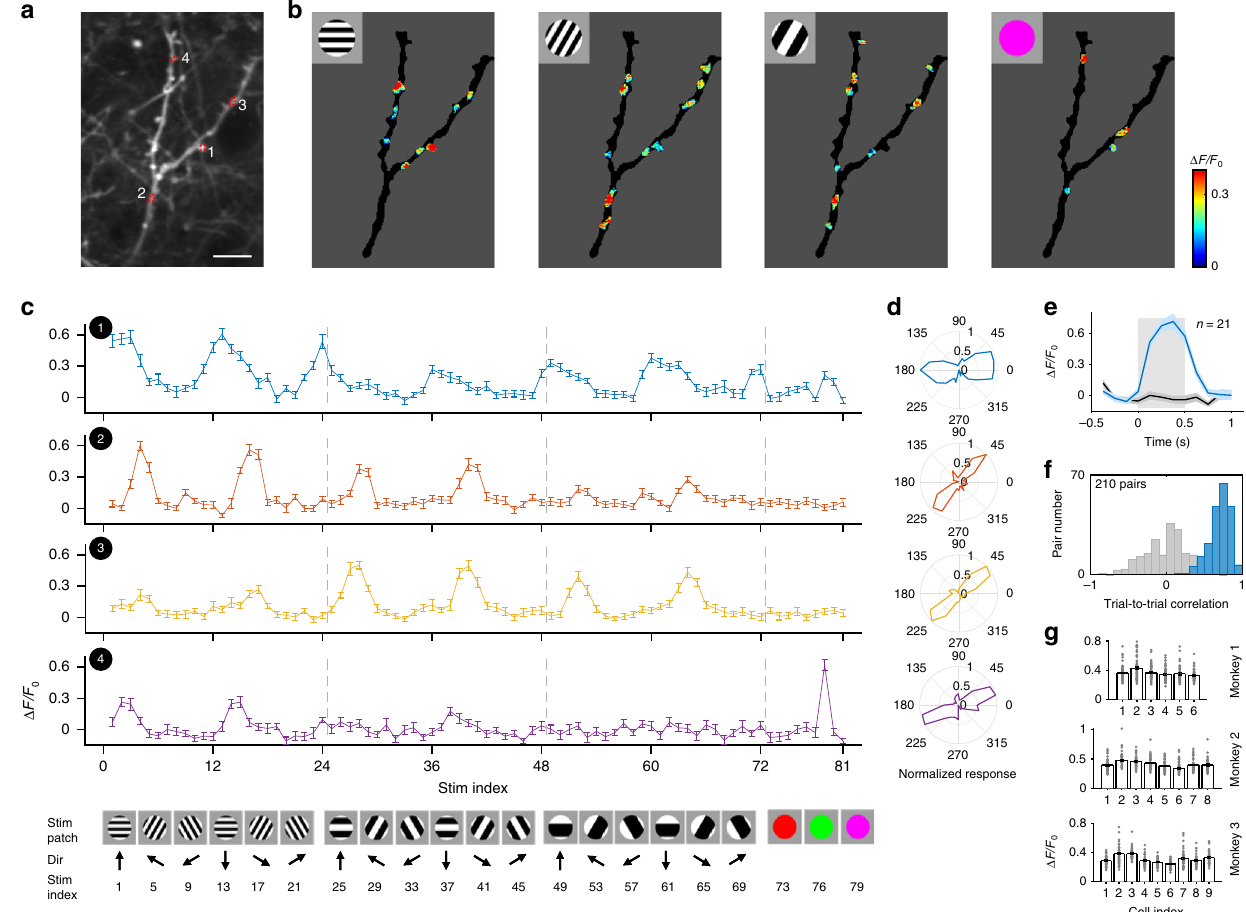
Fig. 1 Imaging excitatory inputs on dendritic shafts in awake macaque monkey V1. a Dendritic shafts of one neuron expressing SF-iGluSnFR.A184S in super fi cial layer of V1, recorded at a depth of 141 μ m on Day 84 post-injection. The image was obtained by averaging 1000 frames from one recording session. Red dotted circles are representative ROIs; scale bar, 10 µ m. b Fluorescent responses (averaged across 21 repeats) on dendritic shafts elicited by visual stimuli (insets). Only robust input activities within regions (of >2.5 STD over baseline) were analyzed. Intensity of iGluSnFR fl uorescence signals are denoted by the colorbar (right). c Responses ( Δ F / F 0 averaged across 21 repeats) from the numbered ROIs from panel a , plotted as a function of stimulus (below; error bar, SEM). Top, response curves; bottom, a subset from the entire set of 81 visual stimuli. d Orientation polar plots from the optimal SF for each ROI. e Fluorescence traces of ROI 1 corresponding to the highest (Stim index = 13, blue) and lowest (Stim index = 81, black) response intensity from all stimuli tested. Curve shadow, SEM; square shadow, stimuli onset interval. f Repeatability of worst (gray) and best (blue) stimulus responses across trials as in e were calculated as trial-to-trial correlations. g Mean value of the optimal response to each of the 1818 ROIs averaged with each the 23 source neurons (presented separately by monkey; error